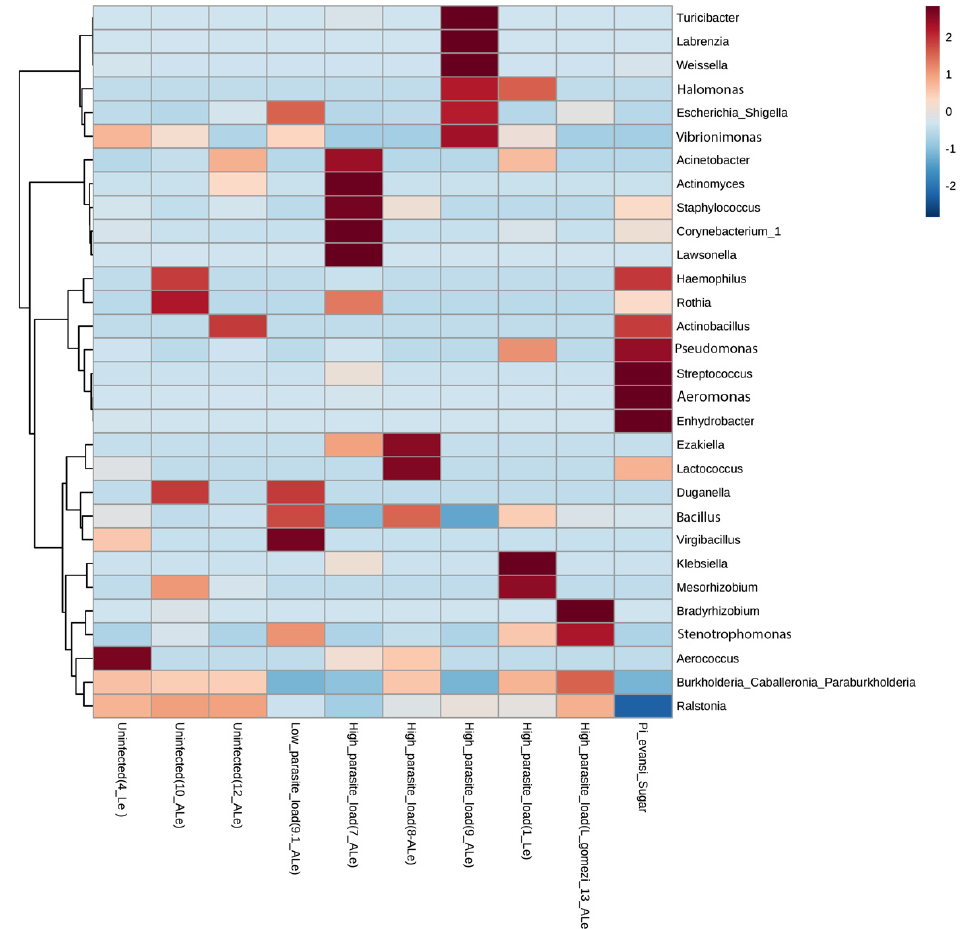
Figure 3. Heatmap based on microbiota composition at genus level associated with gut microbiota in wild specimens of P. evansi from the north of Colombia, infected with Leishmania and treated with antibiotics. Hierarchical Ward’s linkage clustering based on the Pearson’s correlation coefficient of the microbial taxa abundance. Blue and red colors represent positive and negative correlations, respectively. The color scale represents the scaled abundance of each variable, denoted as Z-score, with red indicating high abundance, and blue indicating low abundance.